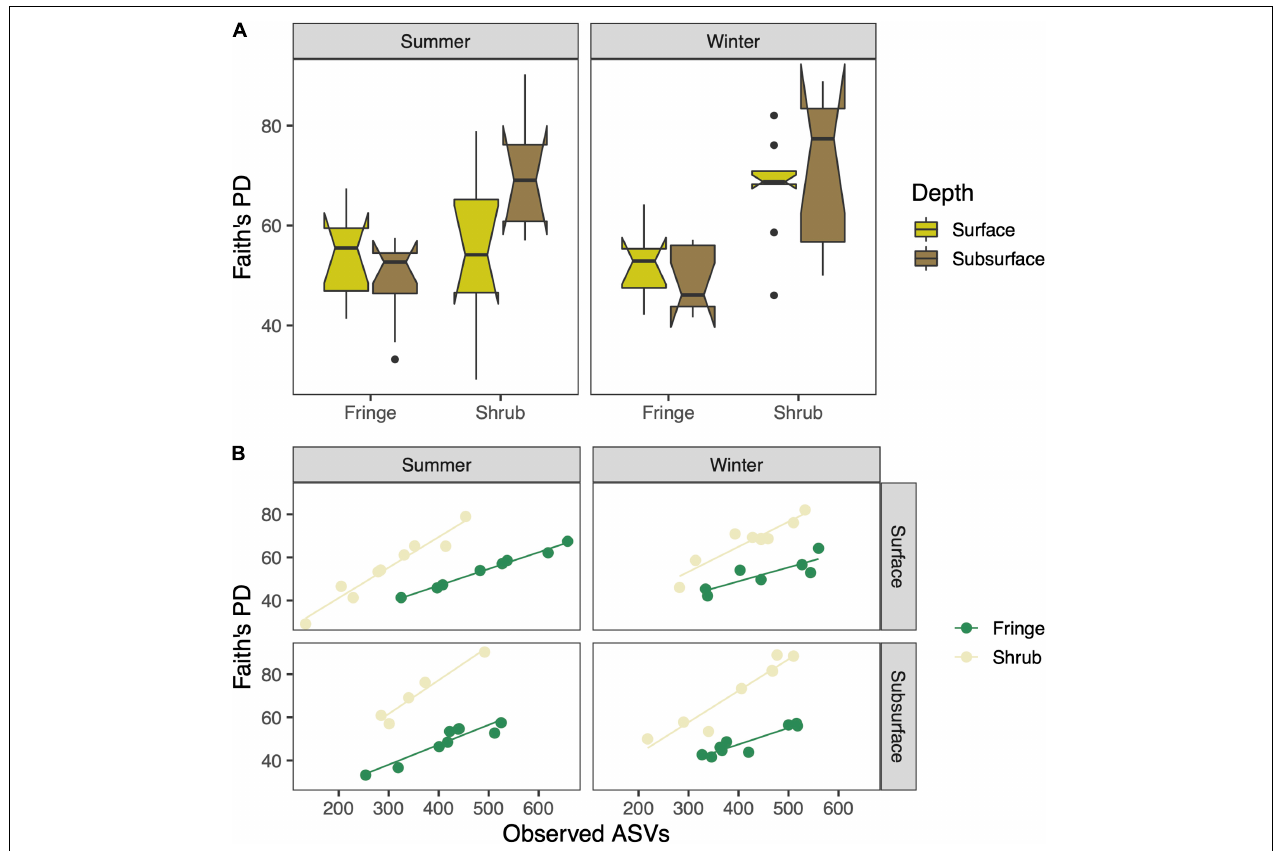
FIGURE 3 | (A) Faith’s phylogenetic diversity index which expresses the sum of all branch lengths of the phylogenetic tree. (B) Correlations between species richness and phylogenetic diversity. The boxplots indicate the median with the interquartile range (IQR) between the 25th and the 75th percentile and the whiskers extend 1.5*IQR. Boxes were plotted with the notch ( ± 1.58*IQR/sqrt[n]) to display likely statistical significance if notches do not